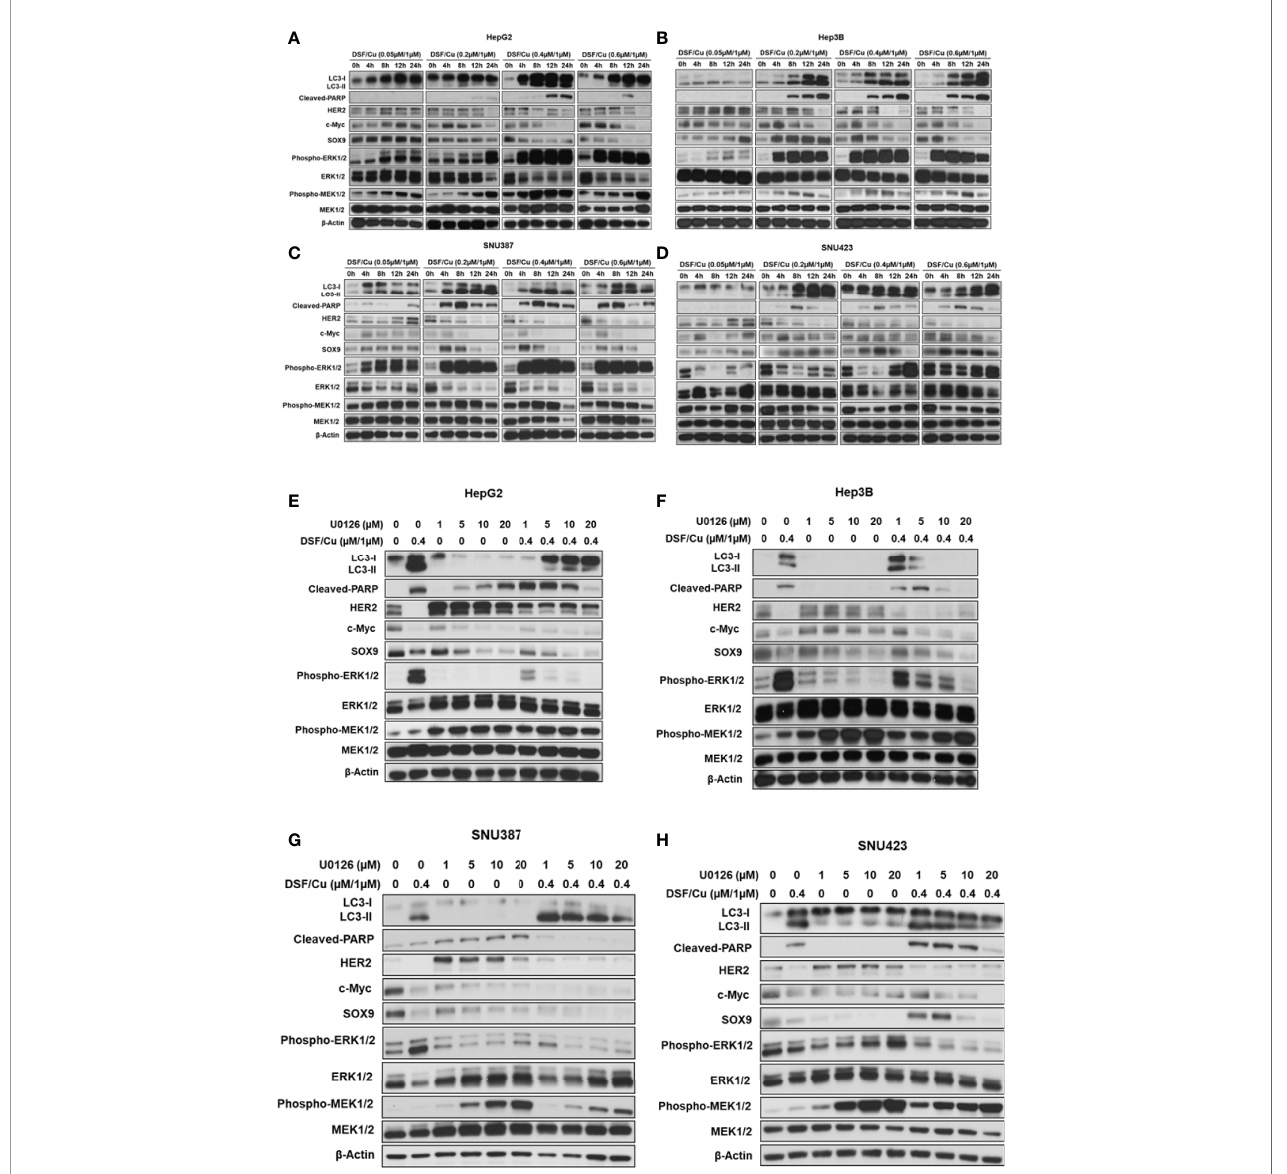
FIGURE 5 | DSF/Cu induces autophagic cell death via sustained activation of the ERK signalling pathway in vitro . The HCC cell lines HepG2 (A, E) , Hep3B (B, F) , SNU387 (C, G) , and SNU423 (D, H) were treated with different doses of DSF/Cu in the presence or absence of U0126. Treated cells were lysed at different time points and analysed by western blot for the expression of stemness genes encoded proteins, autophagy, apoptosis markers, and MEK/ERK pathway activation- related